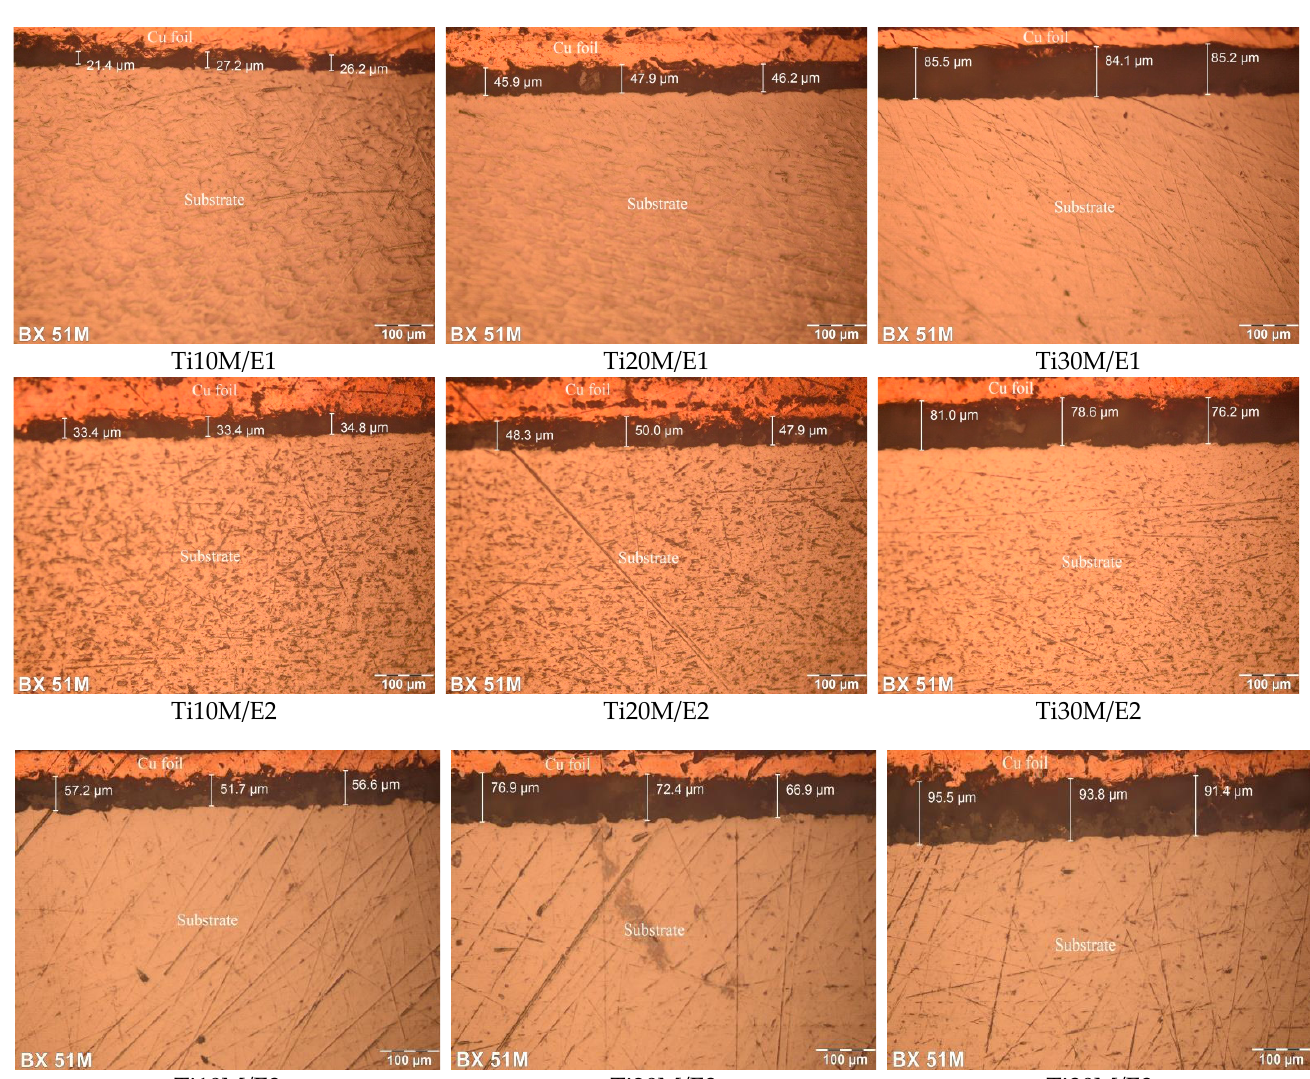
Figure 3. Qualitative phase analysis of the diffraction patterns of the Ti10M/E1 ( a ) and Ti30M/E1 ( b ) samples, before (1) and after (2) removing a 10 µm-thick surface layer. 1: α -Al 2 O 3 ; 2: γ -Al 2 O 3 ; 3: TiAl 2 O 5 ; 4: Na 2 Ti 4 O 9 ; S: Cp-Ti grade 2.